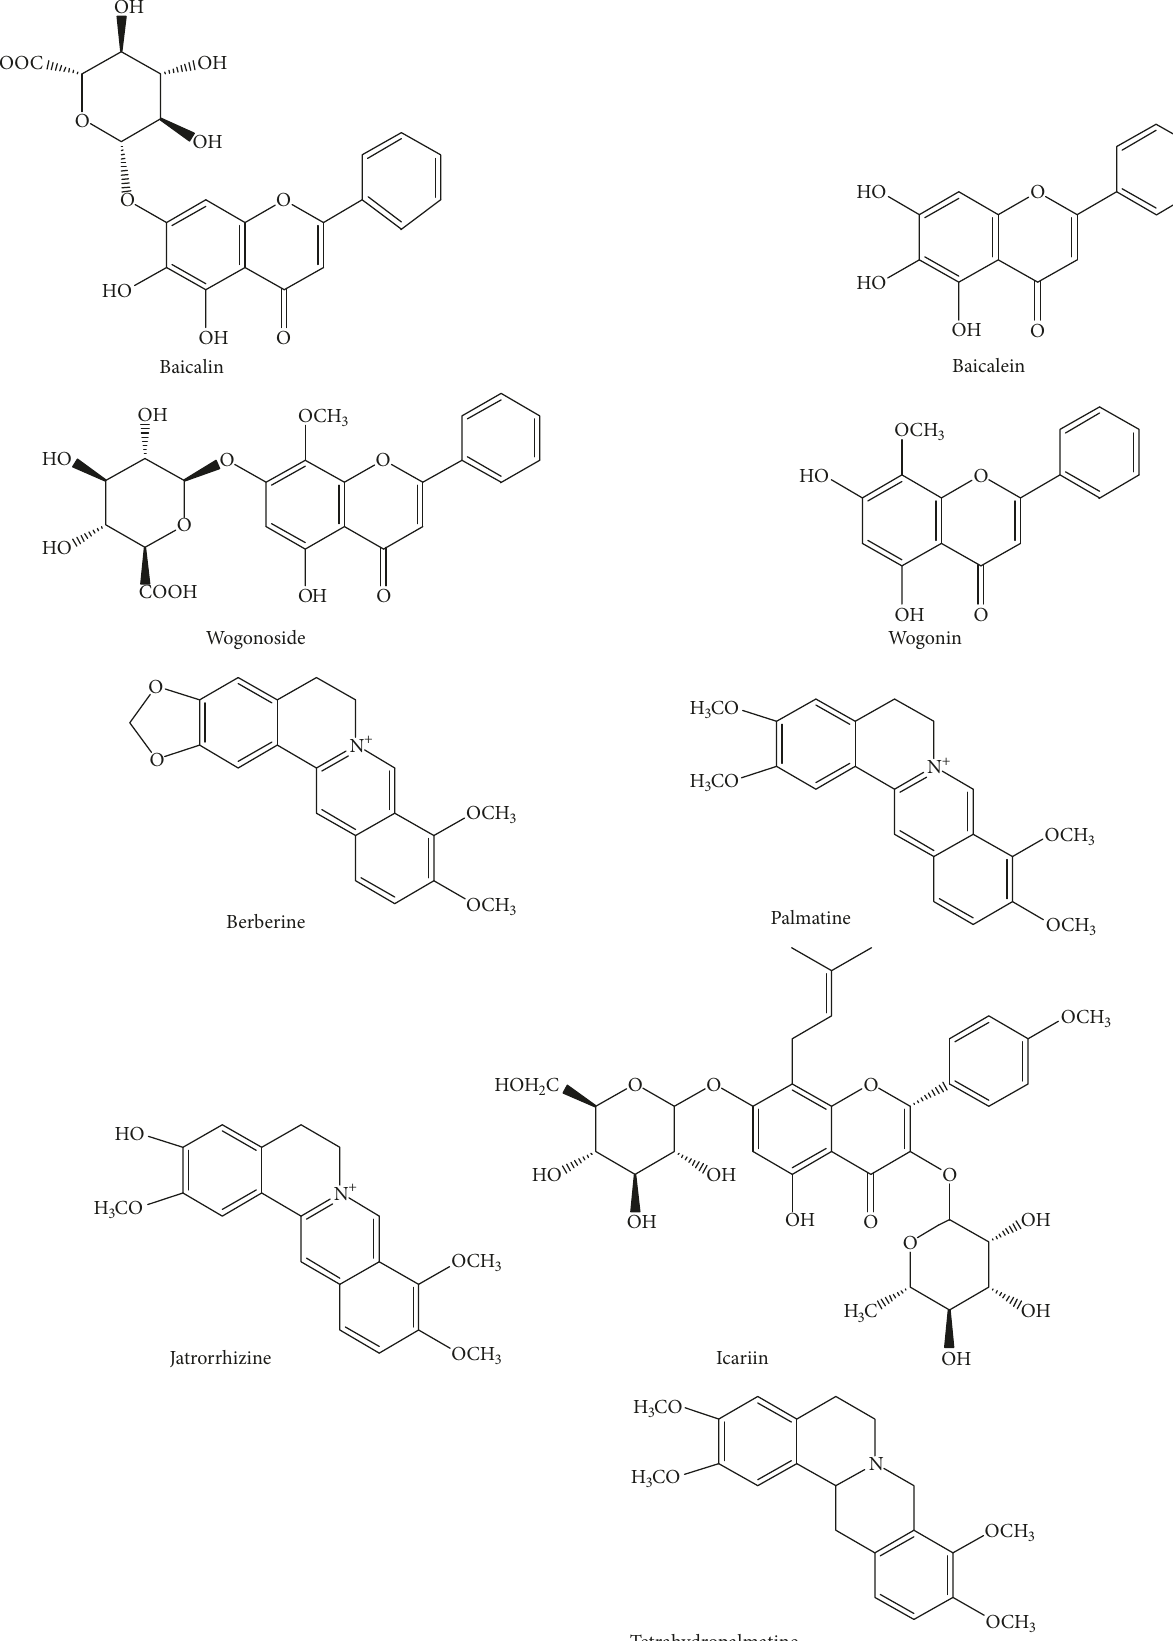
Figure 1: Chemical structures of baicalin, baicalein, wogonoside, wogonin, berberine, palmatine, jatrorrhizine, icariin (I.S.), and tetrahydropalmatine